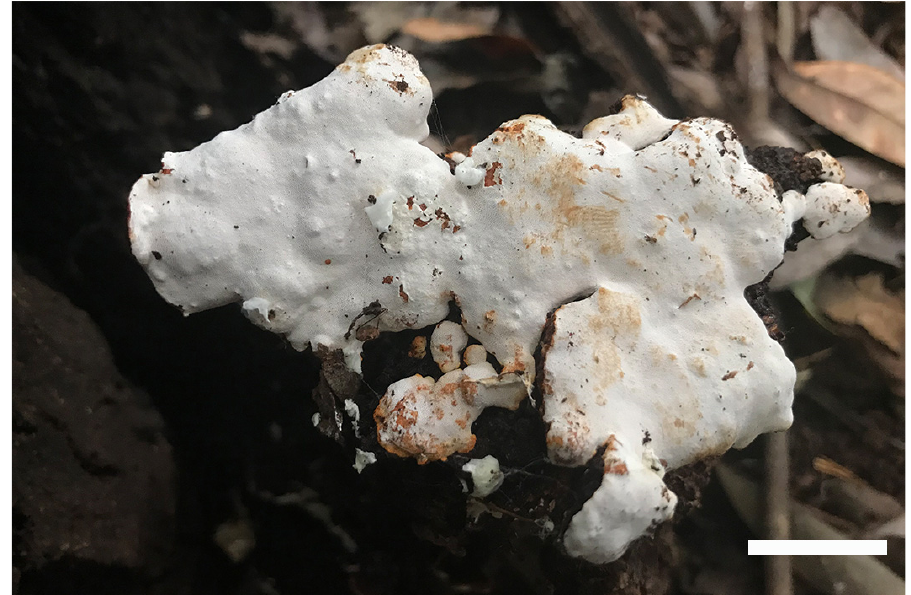
Figure 5. Basidiocarp of Niveoporia subrusseimarginata (Holotype). Scale bar = 2.0 cm.